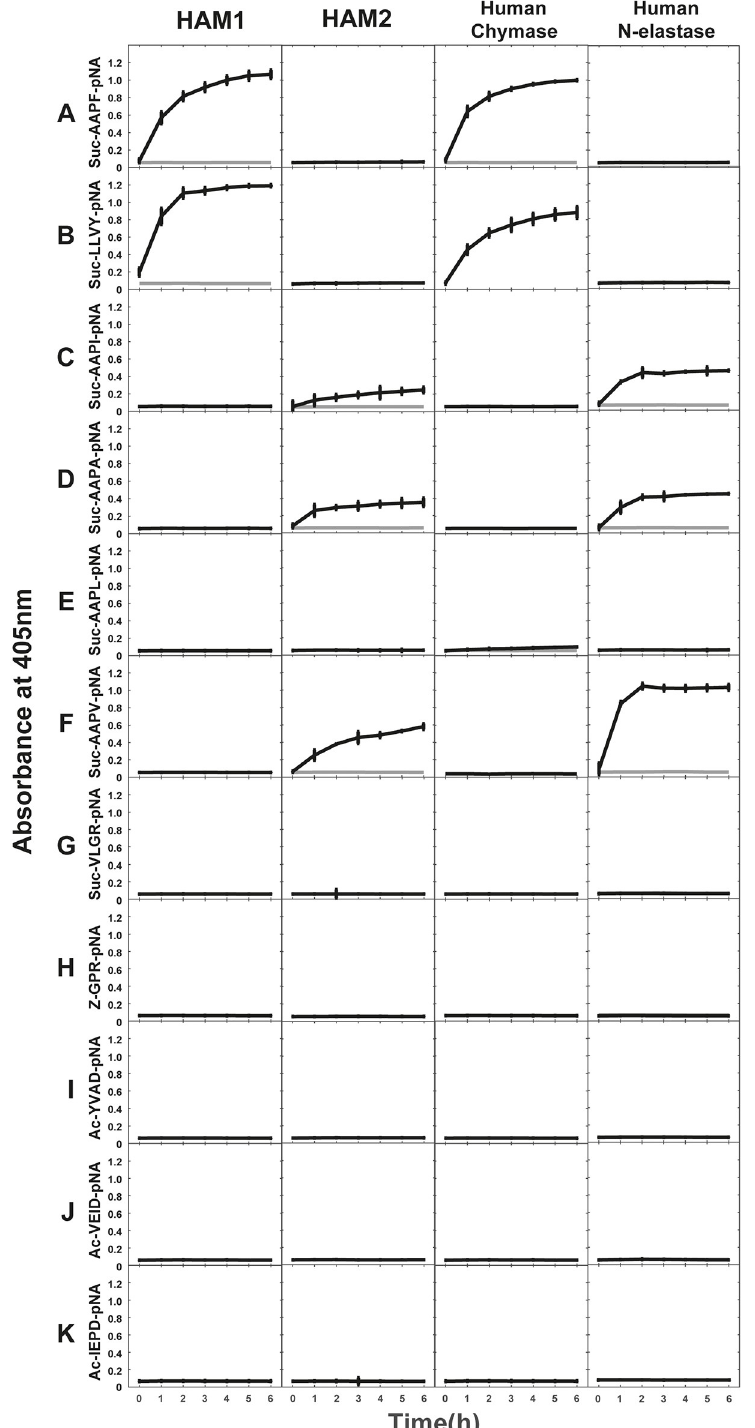
Fig 3. Chromogenic substrate assays. A panel of chromogenic substrates was used to determine the primary specificity of HAM1 and HAM2. Specificities of the human chymase and human neutrophil elastase are presented as reference. The panel includes different chymase, elastase, tryptase and aspase substrates. The amino acid sequences of the substrates are listed at the left side of the panels. The analyses were done in triplicates and the standard deviation within these triplicates is presented in the